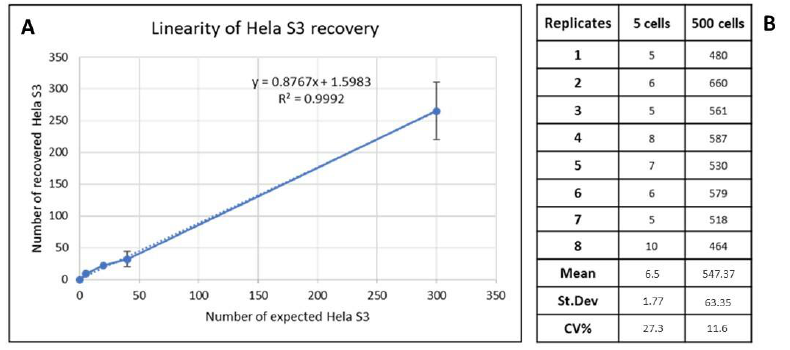
Figure 1. ( A ) Dashed and solid lines represent the assay linearity: plot of recovered Hela S3/slide ( y -axis) versus the theorical number of Hela S3/slide ( x -axis). The linear regression was calculated. ( B ) Assay reproducibility calculated for 5 Hela S3 and 500 Hela S3 spiked per slide. St. Dev, standard deviation; CV, coefficient of